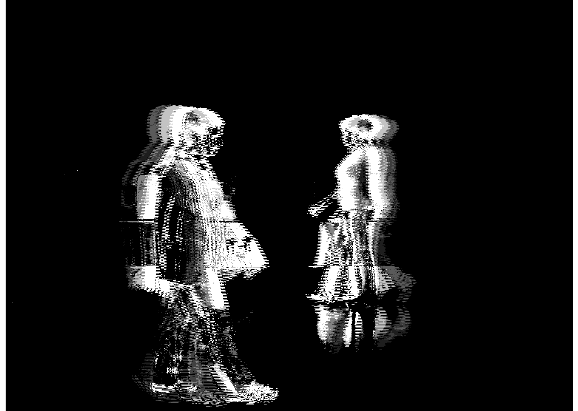
Figure 12. Total charge for N th = 30 B